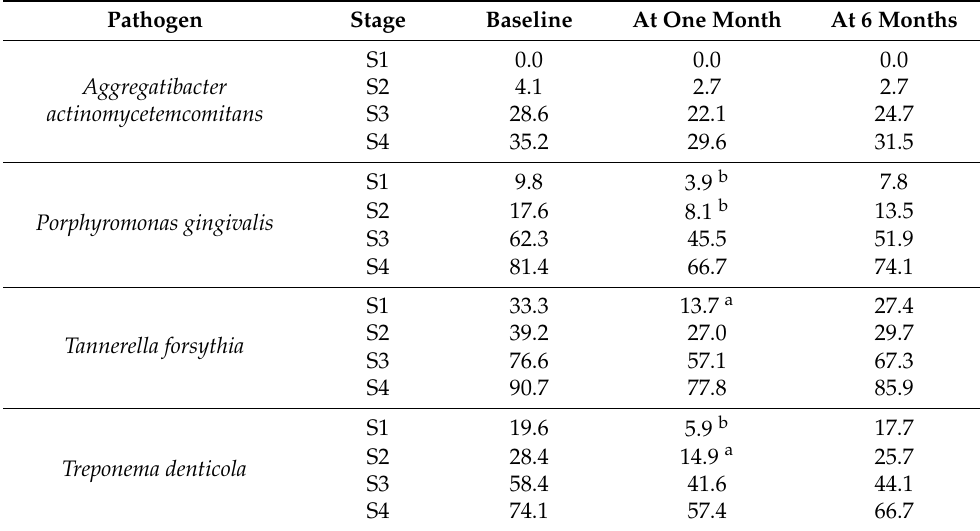
Table 9. Periodontal pathogens detection at baseline and after treatment (one month and six months) for the control